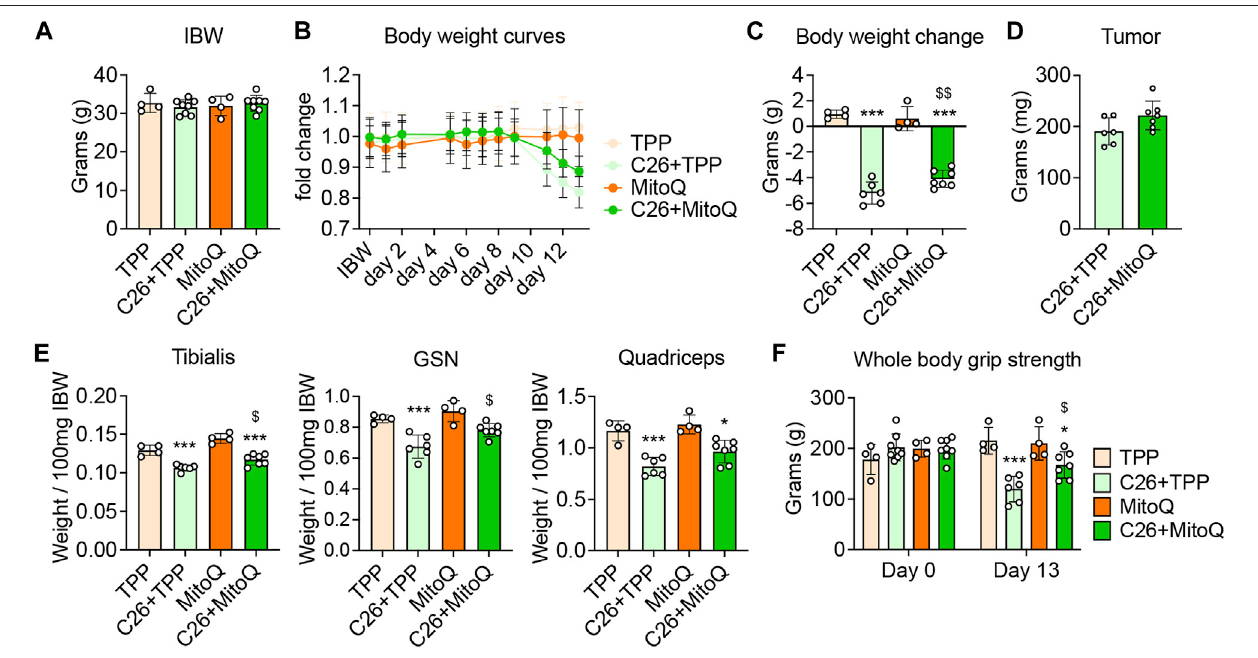
FIGURE 2 | MitoQ treatment increases body weight in C26 hosts and partially corrects muscle mass and weakness. (A) Initial body weight (IBW) expressed in grams,recordedthedayoftumorinoculation. (B) Bodyweight(BW)curves. (C) BWchangeattimeofsacri fi ce(vs.IBW). (D) Tumorweightexpressedinmilligrams(mg). (E) Tibialisanterior,gastrocnemius(GSN)andquadricepmusclemassnormalizedtoinitialbodyweight(IBW)andexpressedasweight/100 mgIBW. (F) Wholebodygrip strength (expressed in grams of force). Statistical signi fi cance was evaluated by two-way analysis of variance, and signi fi cant differences (at least p < 0.05) were reported as: * p < 0.05, *** p < 0.001 vs. TPP; $ p < 0.05, $$ p < 0.01 vs. C26 +